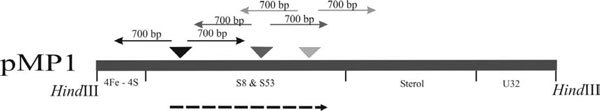
Schematic representation of the insert metagenomic DNA and the position of transposon used for sequencing the coding region. Each inverted triangle represents the individual insertion of transposon in the protease coding gene. Black dotted arrow indicates the orientation and location of protease gene. 4Fe-4S represents 4Fe-4S ferredoxin iron-sulfur binding domain protein, S8 & S53 - peptidase S8 and S53 subtilisin kexin sedolisin, sterol - Sterol-binding domain protein, U32 - peptidase U32.